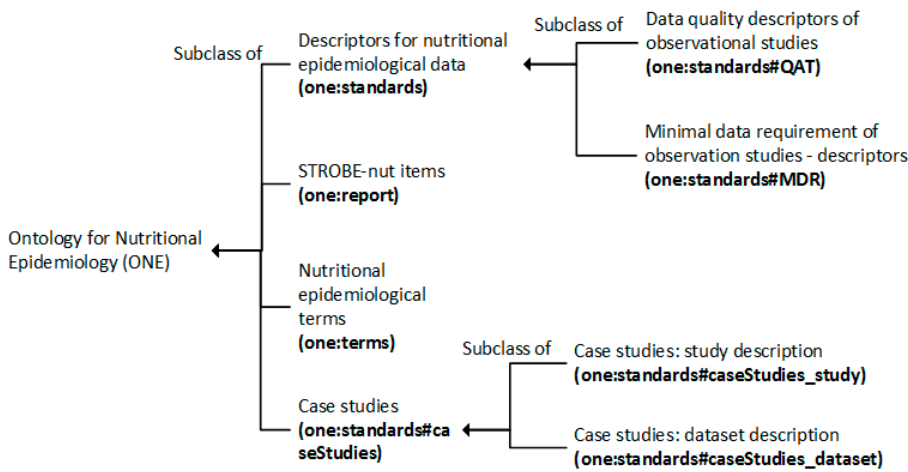
Figure 2. The overall structure of the ontology for nutritional epidemiology (ONE).